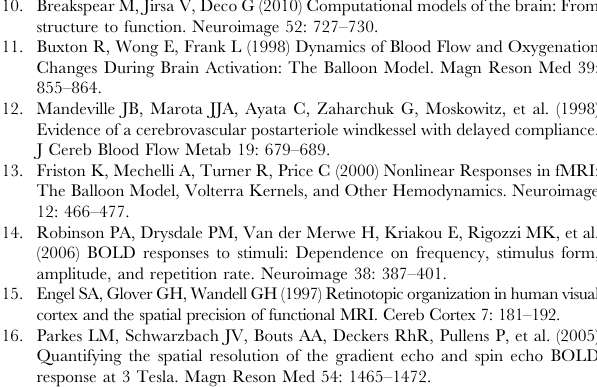
Figure S3 Thresholding the data in V1. A: Frequency responses in all voxels in the occipital pole for each subject, denoted by SXH, (where X is subject number and H is the hemisphere), where the peak at is in red of all subjects. B: The spatial distribution of the Fourier peak frequency response, at 0.1 Hz, where the colors represent normalized power shown in the colorbar. These show the first ring (0.6 u eccentricity and red band closest to the centre) in all subjects with the outer two rings, in most cases, combining. These panels are masked to only include V1 which is overlaid on the flattened occipital pole. C: The complementary eccentricity retinotopic map for each subject, with the colors representing the eccentricity in the visual field, indicated by the filled circle, where the centre represents the fovea the colors extend out radially to the periphery at 5.5 u of eccentricity. Both B